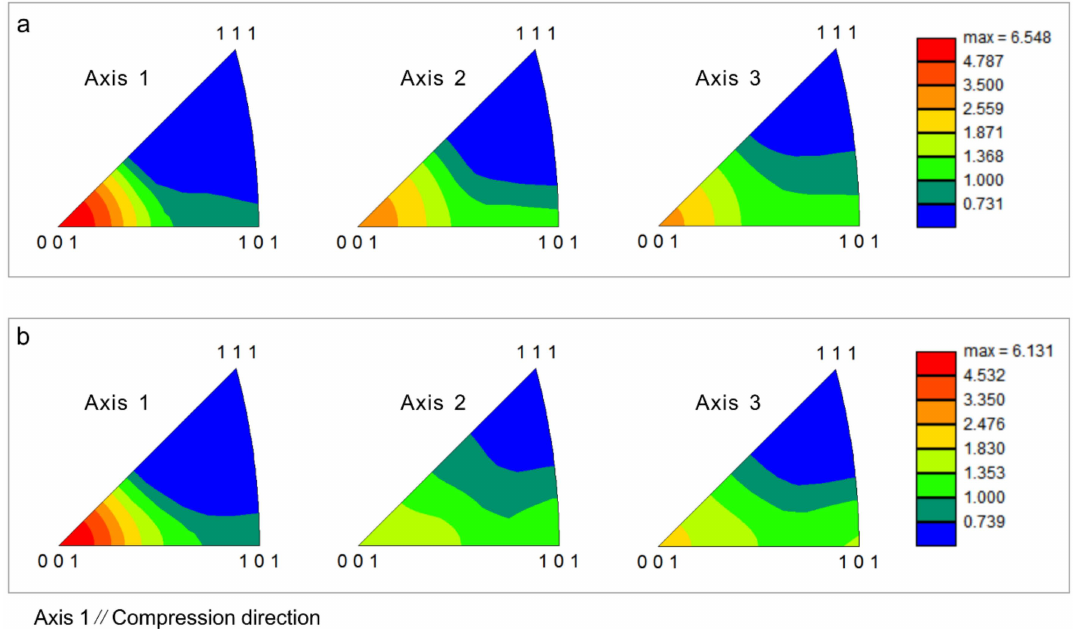
Figure 7. Inverse pole figures of 18Mn18Cr0.6N steel compressed to a strain of 0.8 at different cooling rates: ( a ) 0.0125 Ks − 1 ; ( b ) 0.025 Ks − 1